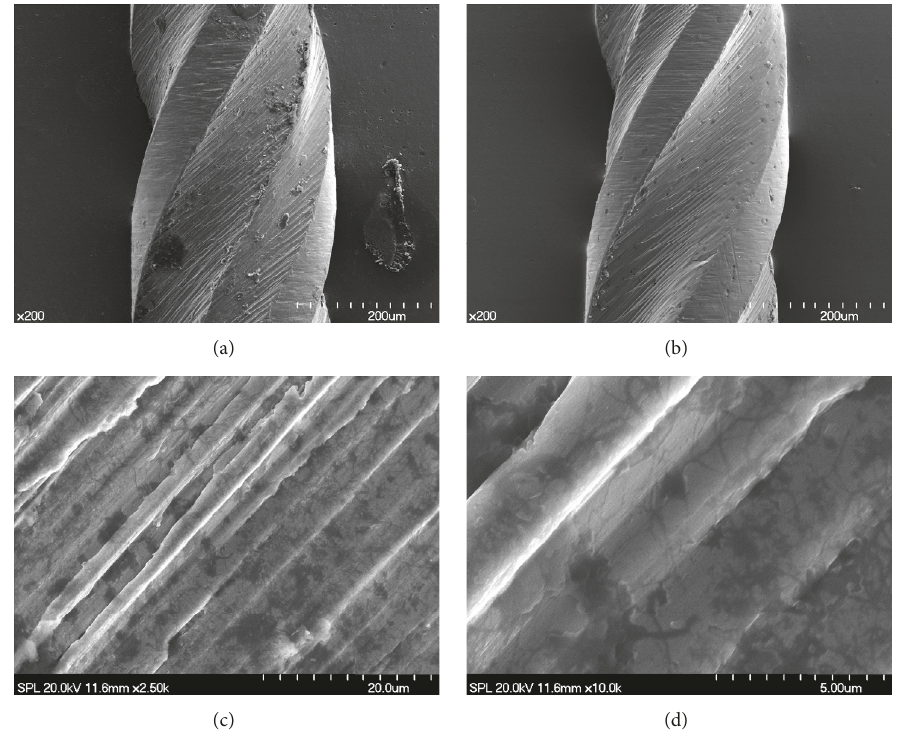
Figure 2: SEM images of the surfaces of as-received and HF-treated K3 instruments. As-received K3 files (a, c) revealed rough surfaces with metal roll-overs and machining marks. On the contrary, the HF-treated K3 (b, d) showed smoothening of rough surfaces. (a) As-received K3 instrument ( × 200). (b) HF-treated K3 instrument ( × 200). (c) As-received K3 instrument ( × 2,500). (d) HF-treated K3 instrument ( × 10,000). SEM: scanning electron microscope; HF: hydrofluoric